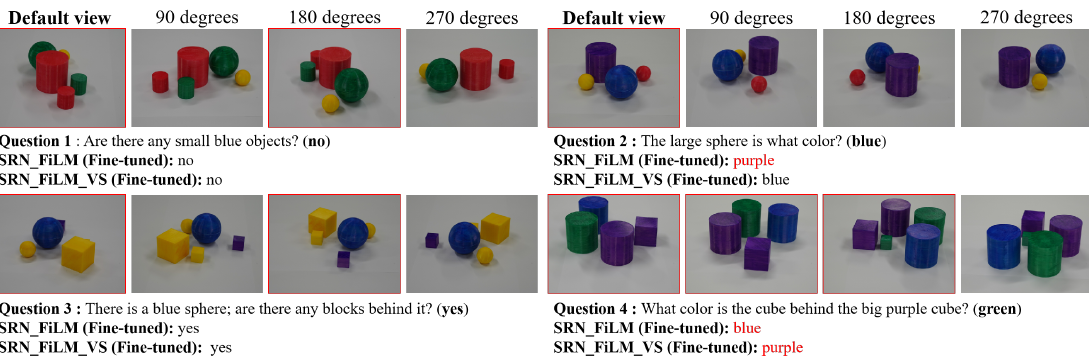
Figure 7. Example results for Multi-view-CLEVR_4views_ Real dataset. The default view and selected view images are highlighted in red bounding boxes. Incorrect answers are shown in